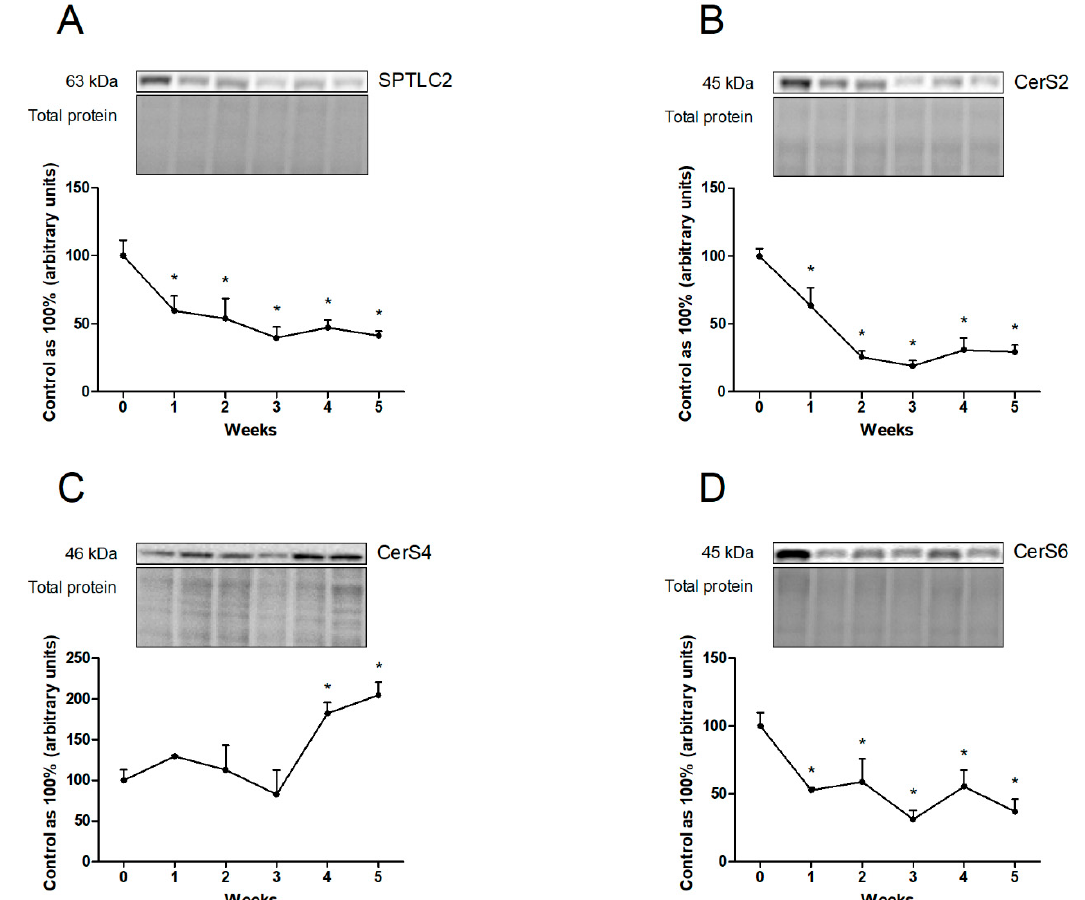
Figure 2. The expression of selected proteins from the ceramide de novo synthesis pathway, i.e., ( A ) serine palmitoyltrans- ferase 2 (SPTLC2) and enzymes that share salvage and de novo synthesis pathways, i.e., ( B ) ceramide synthase 2 (CerS2), ( C ) ceramide synthase 4 (CerS4), and ( D ) ceramide synthase 6 (CerS6) in the liver homogenates. The protein expression was measured using the Western blot technique and presented as a percentage difference compared to the control group, which was set as 100%. The data are presented as mean ± SD and based on n = 6 rats per group in each week of the high-fat diet (HFD). * p < 0.05 significant difference vs. control group (0 week).